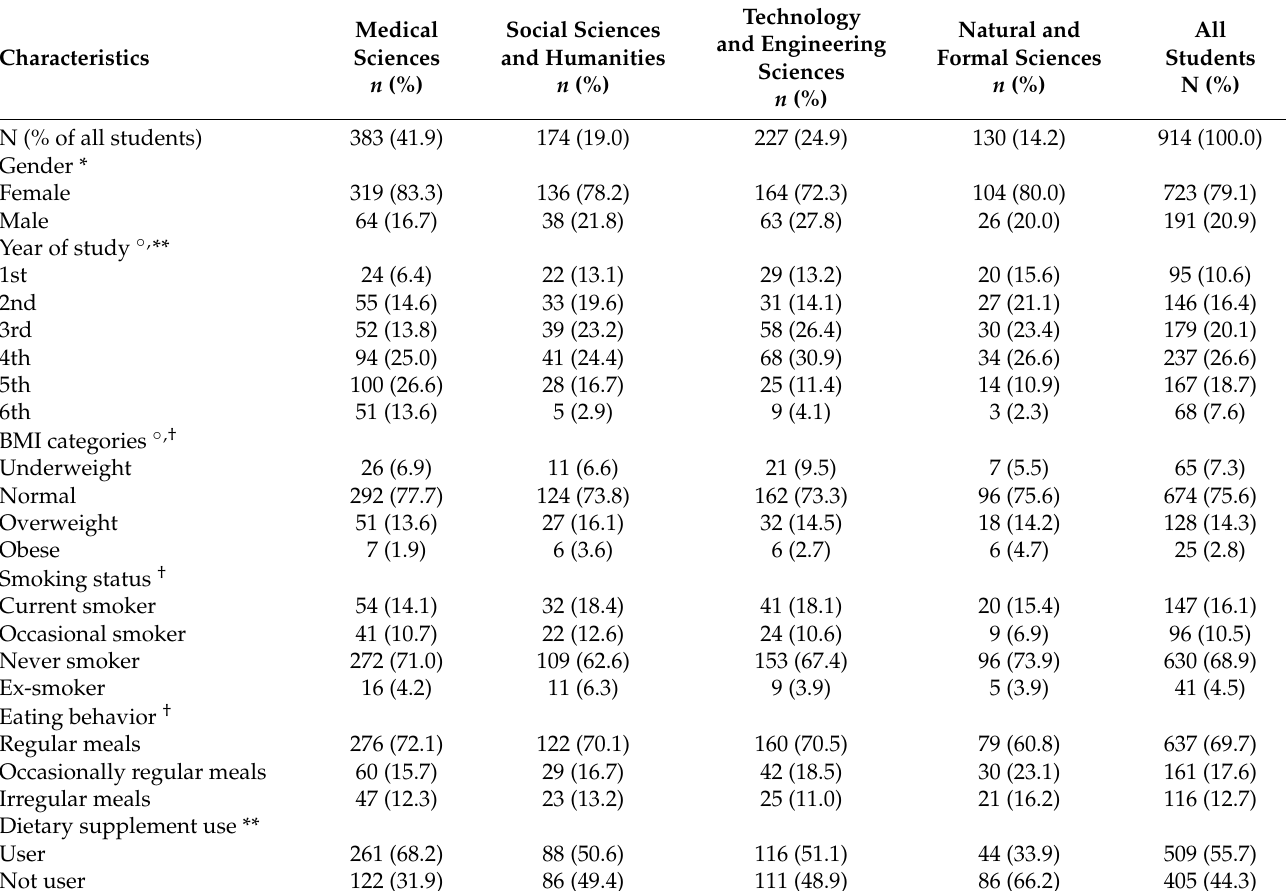
Table 1. Sociodemographic, anthropometric, and lifestyle characteristics of students.